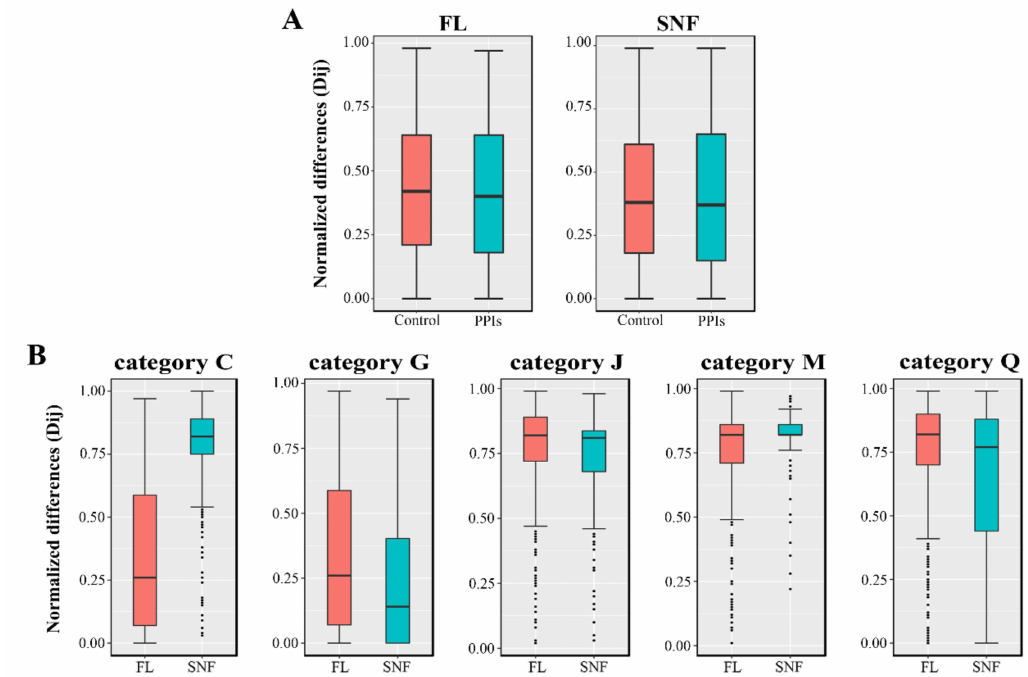
Figure 6. Comparison of normalized transcription level differences of interacting protein pairs. ( A ) Transcription differences in the Free-Living (FL) and Symbiotic Nitrogen Fixation (SNF) states. “Controls”, all pairwise combinations for the proteins in the reconstructed PPI network; “PPIs”, all the interacting protein pairs in the reconstructed PPI network. ( B ) Transcription differences in COG categories for the FL and SNF states. “Category C”, the interacting protein pairs belonging to COG category C (energy production and conversion); and so